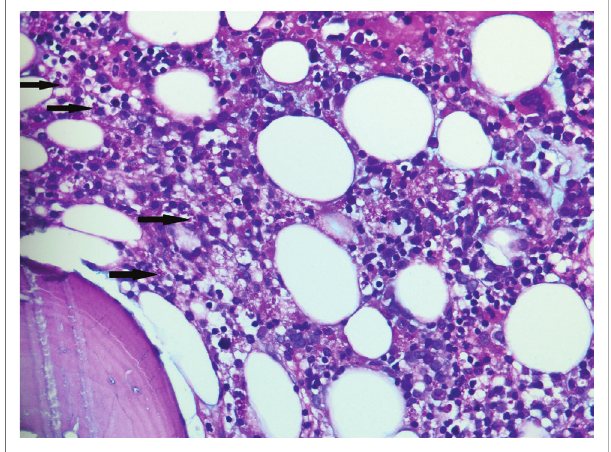
FIGURE 1: Bone marrow trephine biopsy with intracellular fungal yeasts (arrow) that are Periodic Acid Schiff positive with Alcian Blue Periodic Acid Schiff stain (original magnification × 400).